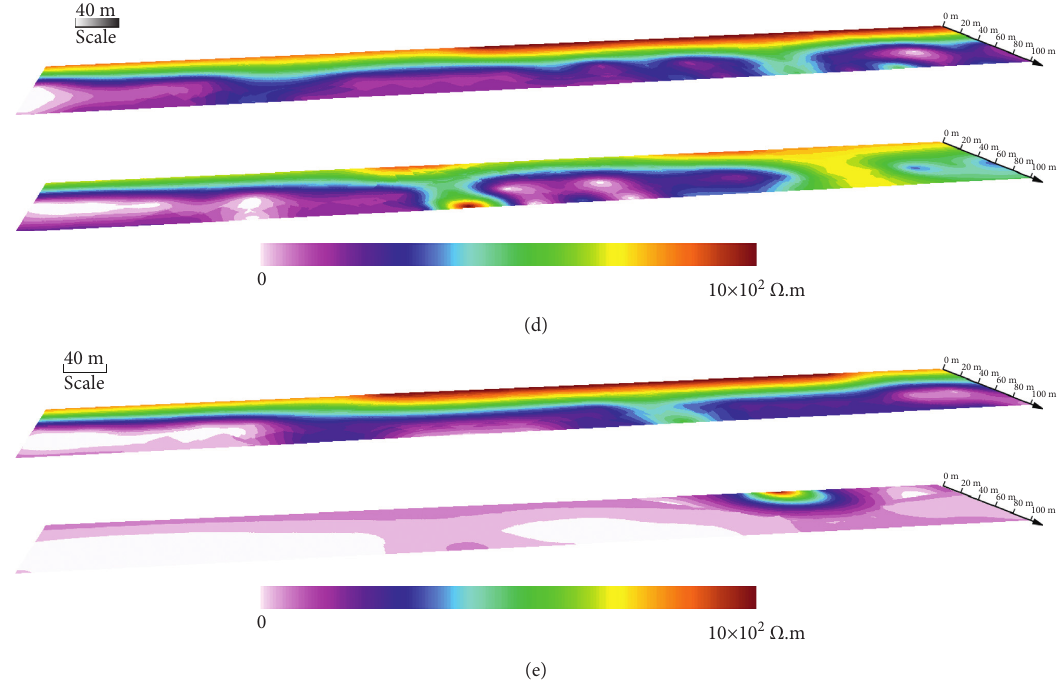
Figure 5: Apparent resistivity of aquifers before grouting.